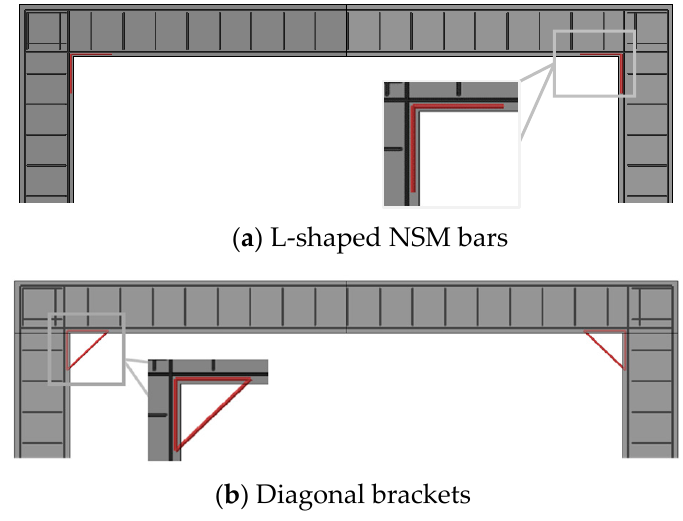
Figure 9. Arrangements of NSM reinforcement.